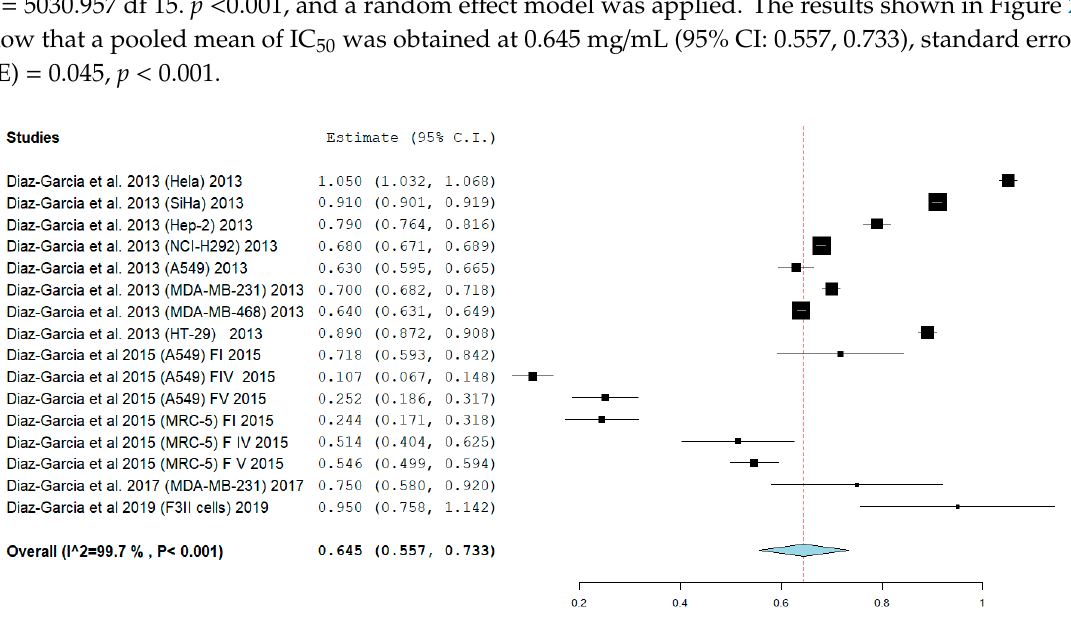
Figure 2. The random effect meta-analysis (Q 5030.957, df 15, I2 99.702%, p < 0.001) IC 50 0.645 mg/mL (95% CI: 0.557, 0.733), standard error (SE) = 0.045, p < 0.001. Legend: Q = Q statistic (measure of weighted squared deviations); df = degrees of freedom; I 2 (I^2) = Higgins heterogeneity index, I 2 < 50%, heterogeneity irrelevant; I 2 > 75%, significant heterogeneity; C.I. = confidence intervals; P = p value. The graph for each study shows the cell lines investigated, the first author, and the date of publication, as well as the measurement of the IC 50 expressed in mg/mL with the confidence intervals reported. The final value is expressed in bold with the relative confidence intervals. The red line shows the position of the average value and the rhombus in light blue shows the measure of the average effect.